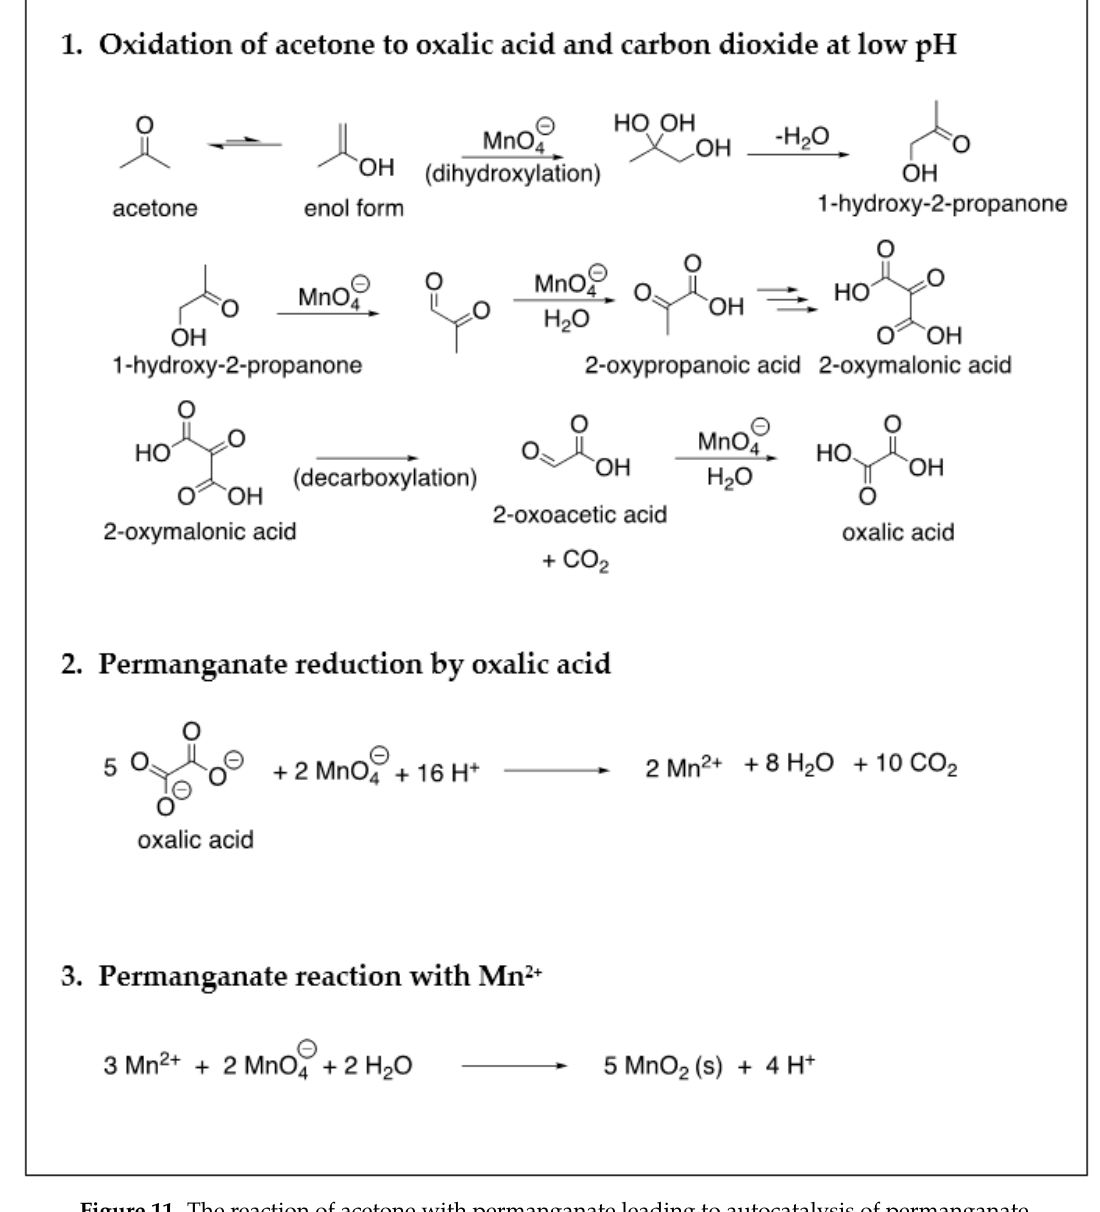
Figure 11. The reaction of acetone with permanganate leading to autocatalysis of permanganate.